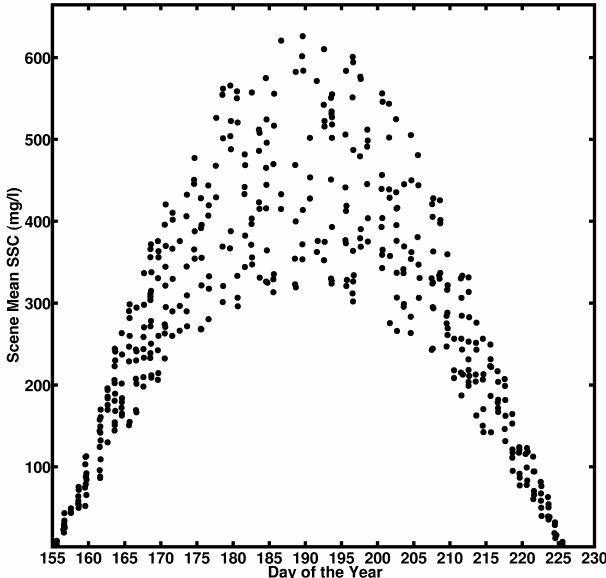
Figure 5. Example of how computational experiment allowed sim- ulated scene suspended sediment concentration (SSC) to vary dur- ring a simulated melt season. For each scene a scene intensity was randomly generated that controls the simulated scene mean SSC (plotted). Three melt seasons are plotted to show a wider range of SSCs allowed.